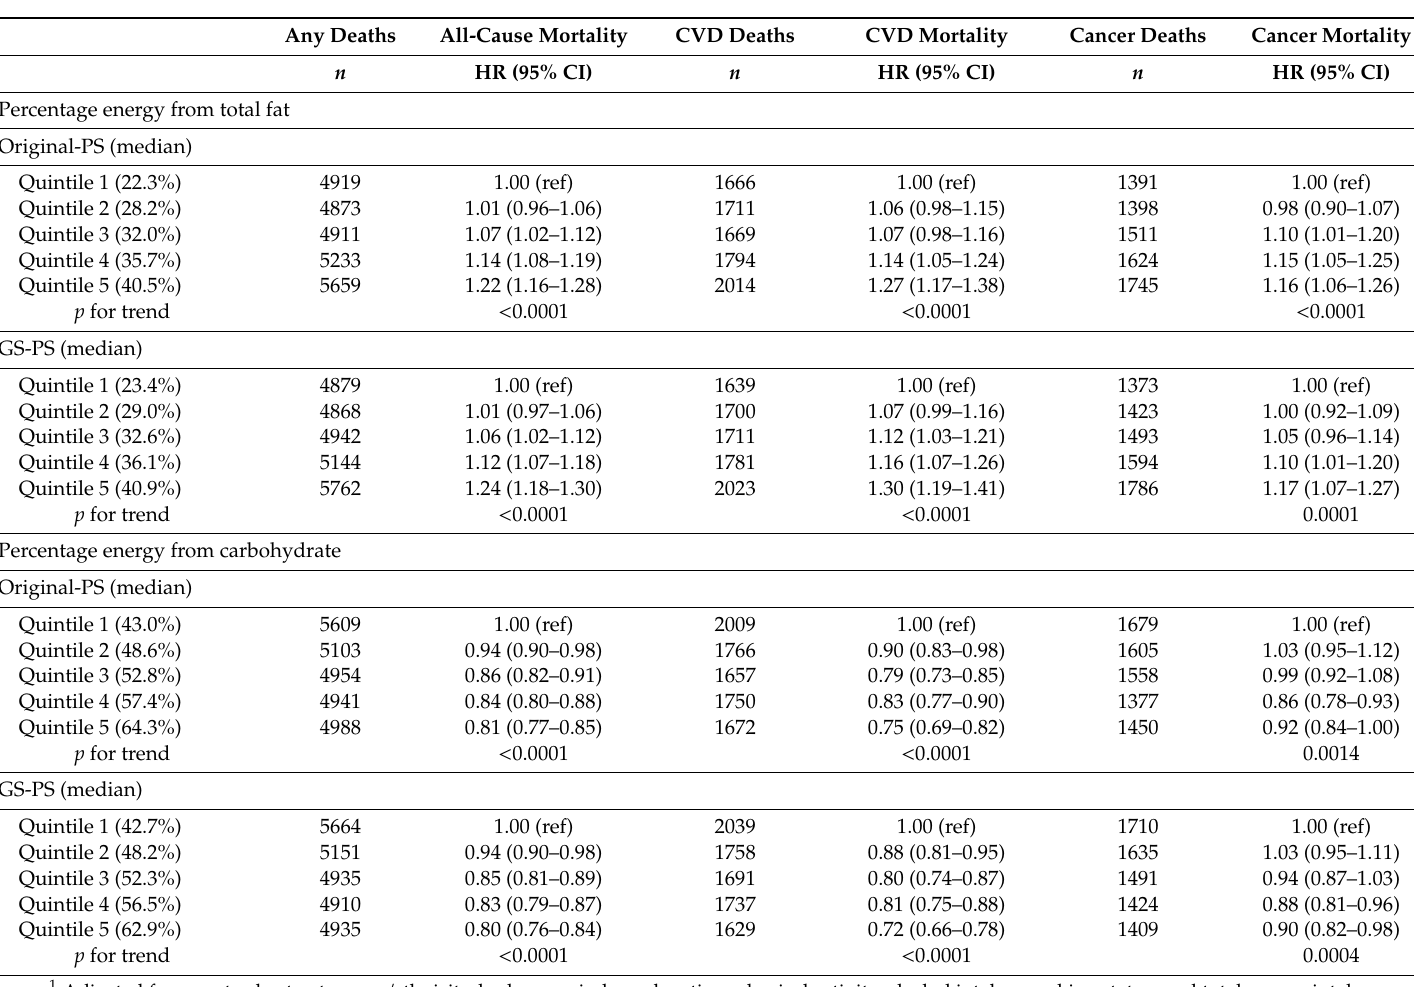
Table 4. Hazard ratios (HRs) (95% confidence intervals (CIs)) for all-causes, cardiovascular disease (CVD), and cancer mortality according to quintiles of percentage energy from macronutrients estimated from a food frequency questionnaire either using an original-portion size (Original-PS) or a gender specific-portion size (GS-PS) among men ( n = 70,142) in the Multiethnic Cohort Study, 1993–2014 1